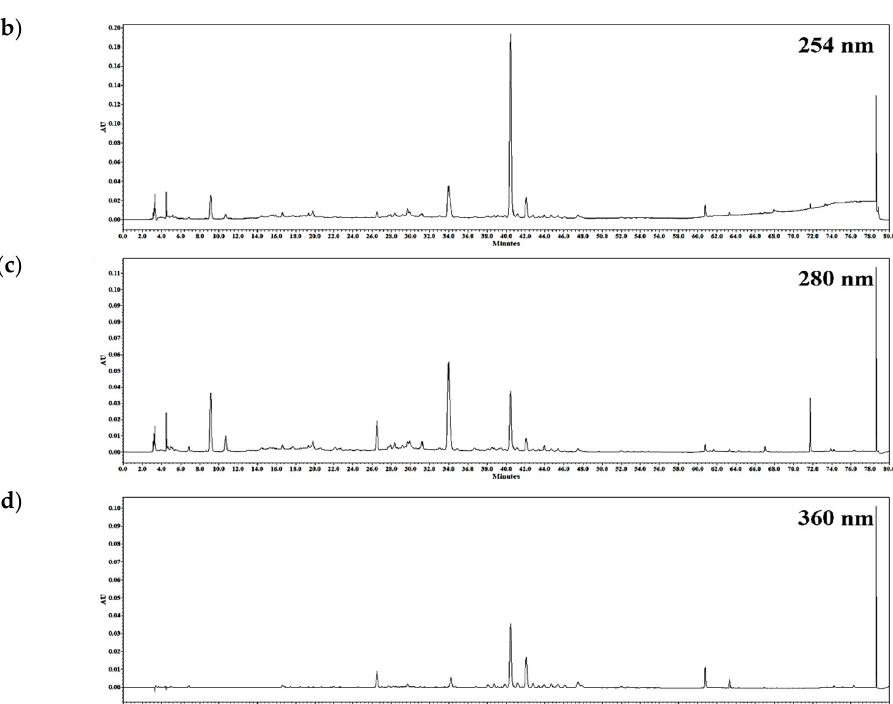
Figure 1. High − performance liquid chromatography (HPLC) profiling of R. davurica Pall . leaf extract (RLE) ( a ) 210 nm; ( b ) 254 nm; ( c ) 280 nm; ( d ) 360 nm.